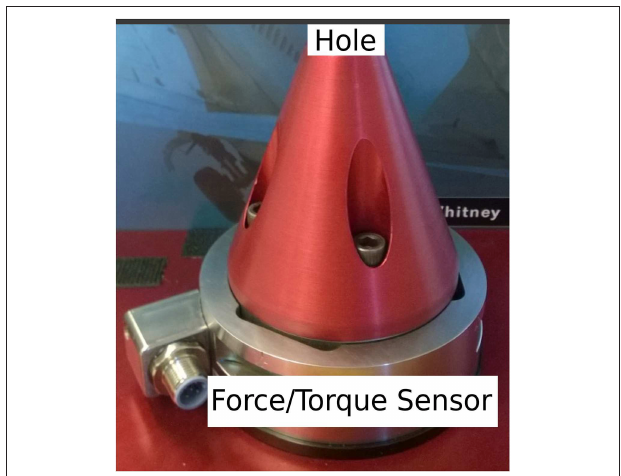
FIGURE 7 | Hole and F/T sensor.